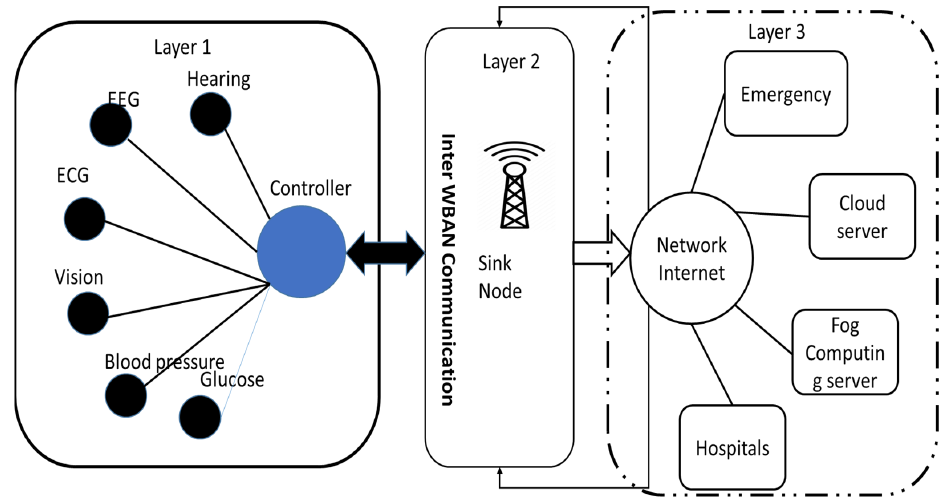
Figure 3. WBASN communication architecture.